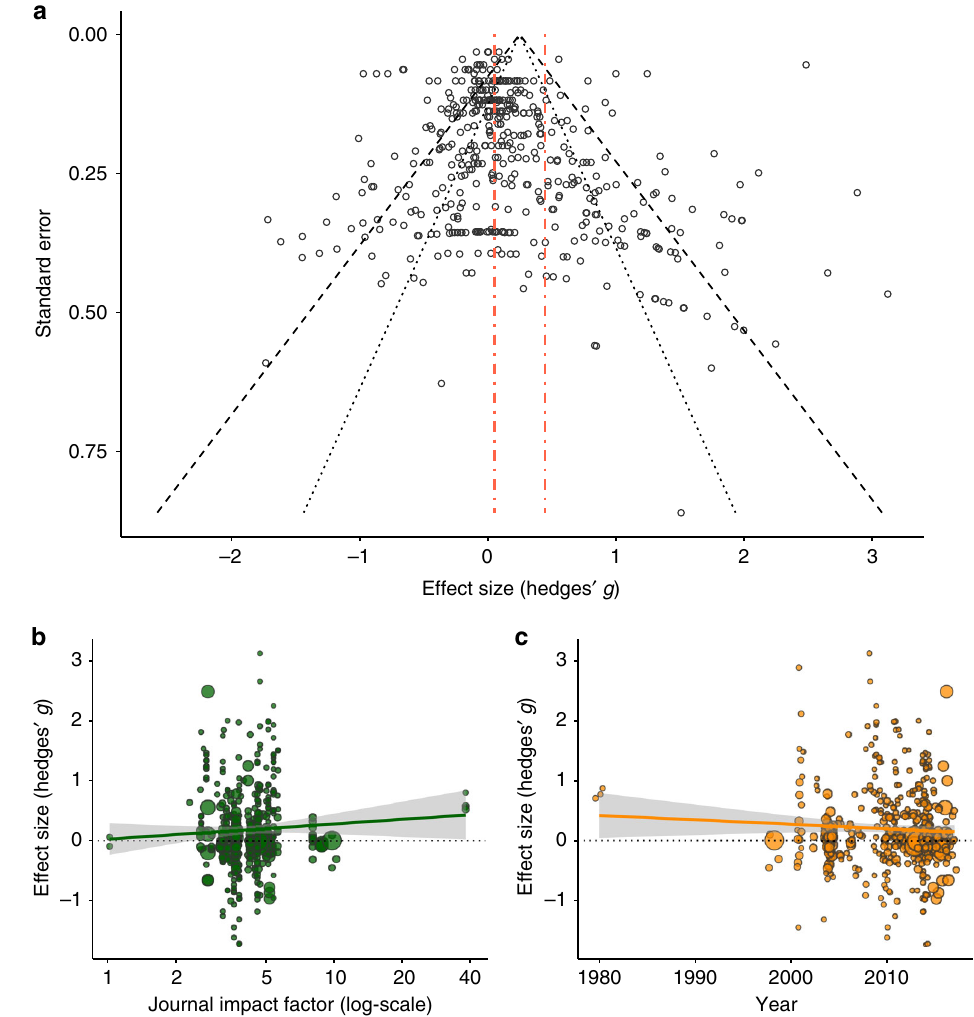
Fig. 3 Tests for publication bias in the dataset. Tests of publication bias are mixed and suggest publication bias may be present. a Inspection and statistical tests of the funnel plot reveal large amounts of heterogeneity in the dataset with asymmetry from increased low-powered, large effect studies. b No signi fi cant correlation exists between journal impact factor and effect size. c additionally there is no signi fi cant correlation between effect size and year of publication when testing for the time-lag bias. For b , c , point size is proportional to the precision of the effect size (i.e. the inverse of its variance). For a , the dashed red lines represent the 95% con fi dence intervals (CIs) of the grand mean estimate for all effect sizes, and the black dotted and dashed lines depict the 95 and 99.8% CIs for the dataset. The grey envelopes in b , c represent the 95% CI of the linear regression. Data used for generating this fi gure are available in the Source Data fi